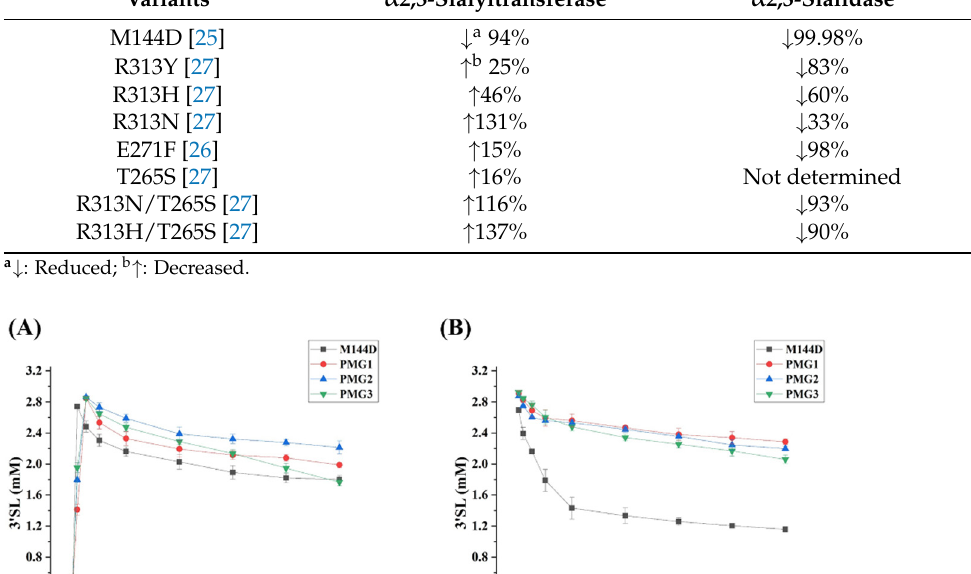
Figure 3. Some of the residues involved in substrate binding. Met144, Arg313, Glu271 and Thr265 in magenta are yet to be investigated. The catalytic residues Asp141 and His311 are in yellow and red. Lactose is in cyan and CMP-Neu5Ac in green. Table 1. Summary of effects of different mutations on ST and sialidase activity in previous studies. Variants